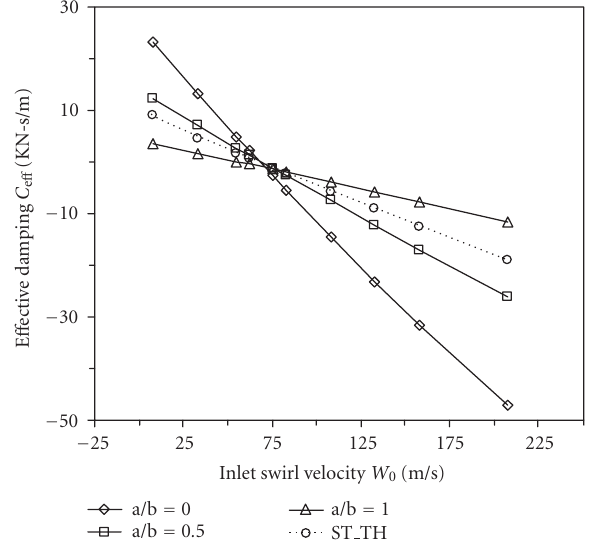
Figure 9: Plot of e ff ective damping C e ff versus inlet swirl velocity ff erent seal W 0 for di